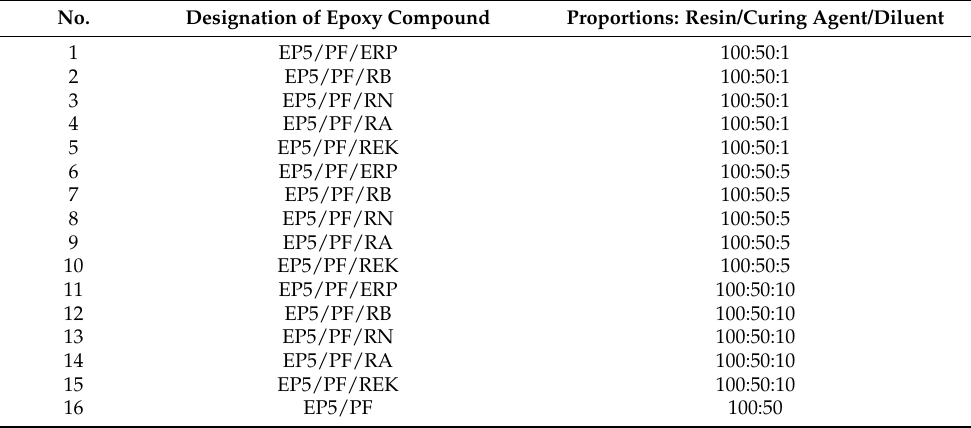
Table 2. Compositions and labels of epoxy compounds based on Epidian 5/PF 100:50.